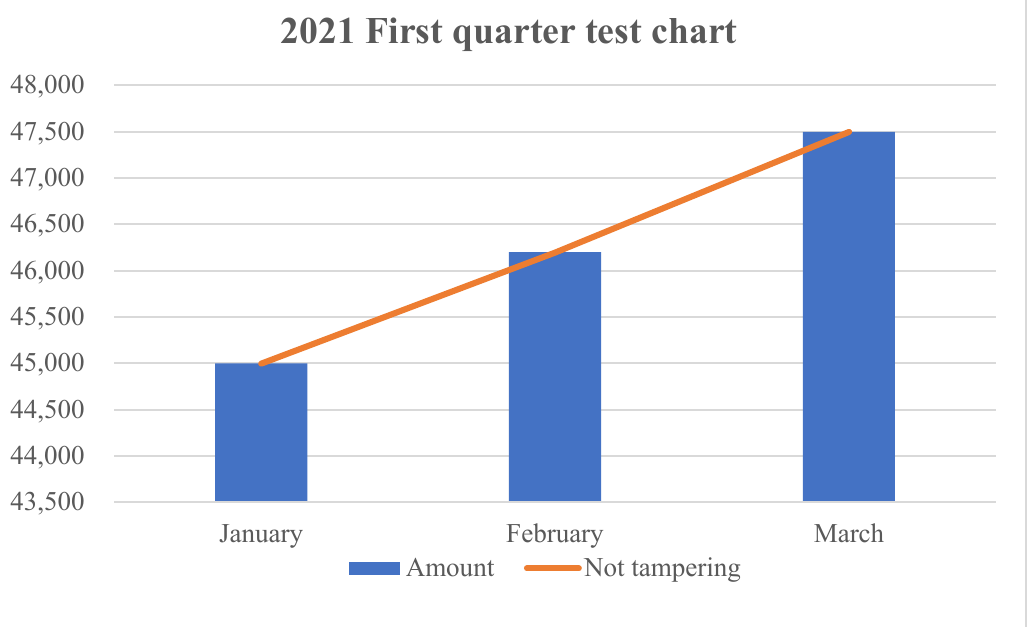
Figure 11. Identification code verification statistics.